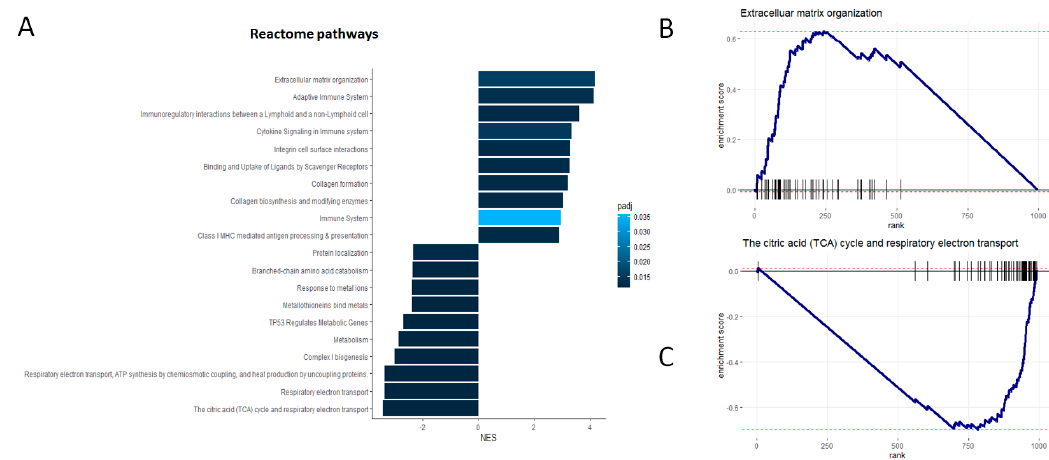
Figure 3. Proteins either strongly positively- or anti-correlated with histology-based predictions are significantly enriched in cancer-relevant molecular pathways. ( A ) List of Reactome pathways that are significantly associated with the proteins on the basis of their correlations with histology-based predictions, as detected by Gene Set Enrichment Analysis (GSEA) (Methods). Bars indicate the magnitude of the enrichment scores, and adjusted p -values of the enrichments are color coded. ( B ) and ( C ) show examples of pathways significantly associated with proteins highly positively- and anti- correlated with histology-based predictions respectively. In ( B ) and ( C ) proteins are ranked according to their correlations with the histology-based predictions, from highest to lowest, and pathway enrichment scores were estimated with GSEA.